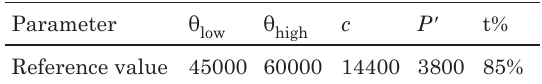
table 3. reference values of parameters